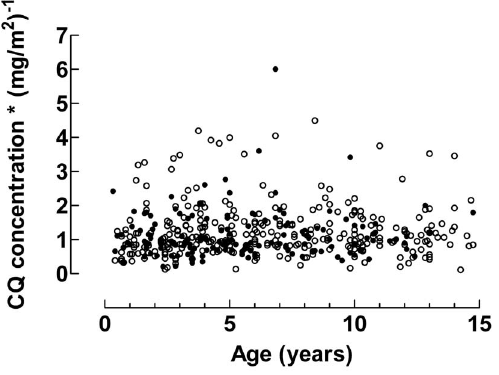
Figure 3. Chloroquine concentrations normalised for mg/m 2 . The dose normalised CQ concentrations were independent of age. The solid line gives the median value of CQ concentrations normalised for N mg/m 2 . Data from patients treated with 25 mg/kg of CQ are given by ) and data from patients treated with 50 mg/kg of CQ closed circles ( are given by open circles ( # ).